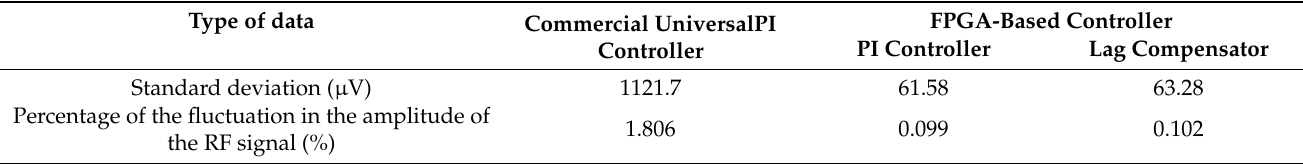
Figure 7. The amplitudes of the RF signal using a commercial universal PI controller and the FPGA-based feedback controllers. Table 1. The fluctuations in the amplitude of the RF signal using a commercial universal PI controller and the FPGA-based feedback controller.